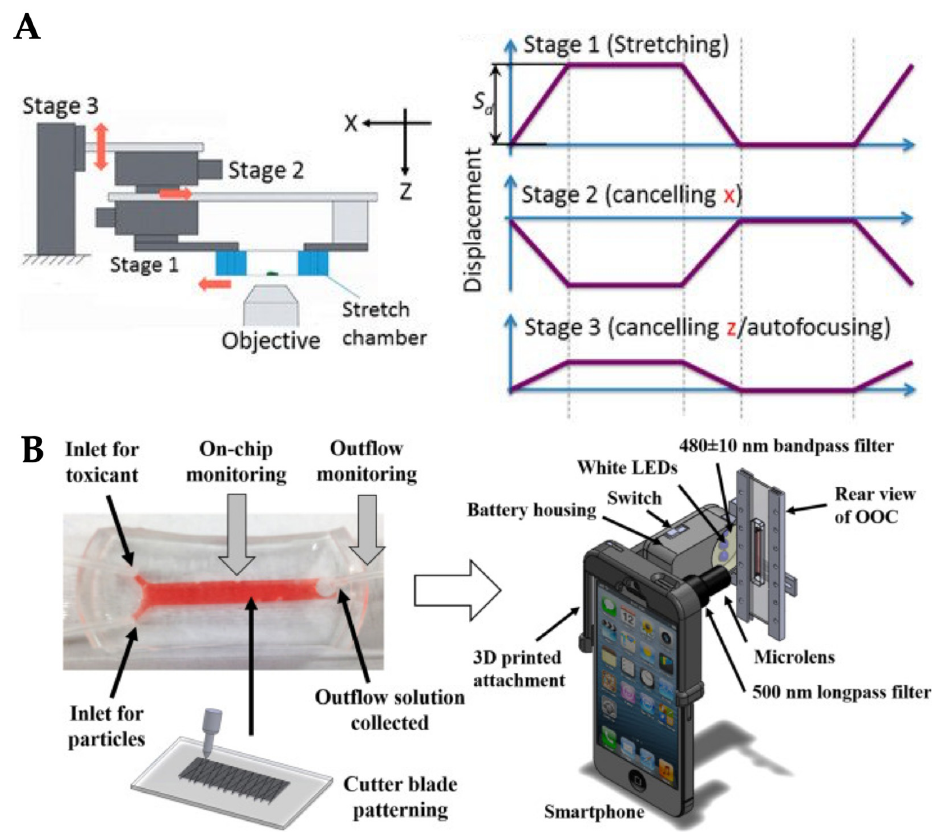
Figure 9. Examples of mechanobiological models and real-time monitoring devices for OOC systems. ( A ) Three motorized stages delivered cyclic stretching and a microscope imaged cellular local displacement. Reproduced with permission from Reference [73]. ( B ) Smartphone-based fluorescence microscope attached to an OOC device for in situ monitoring of nephrotoxicity. Reproduced with permission from Reference